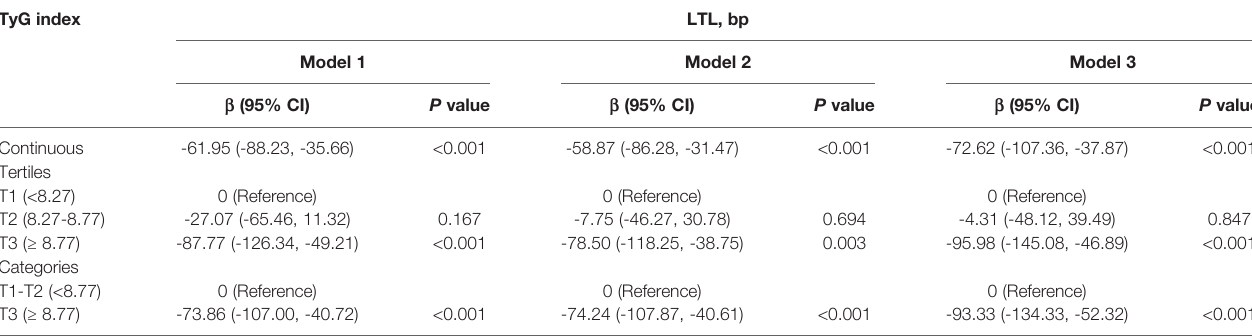
TABLE 2 | Association of the TyG index with leukocyte telomere